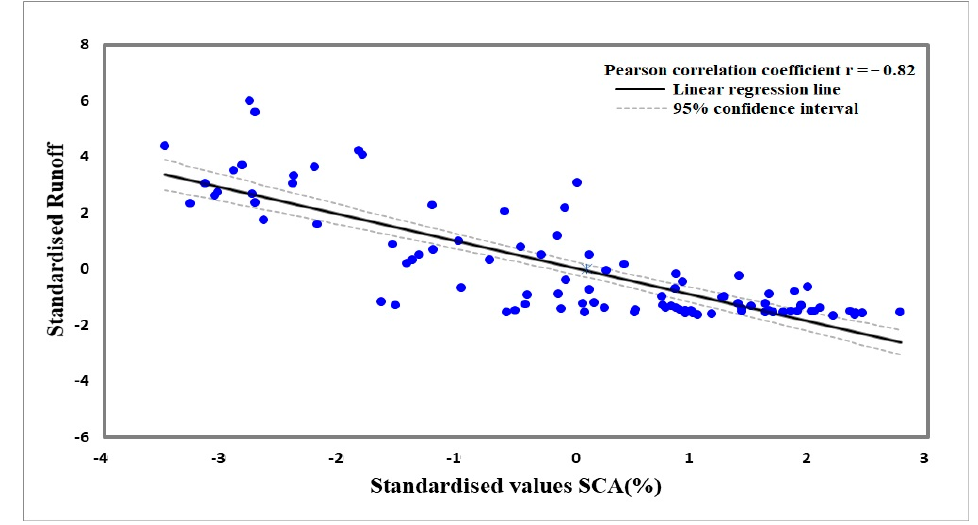
Figure 9. Correlation between standardized values of runoff and SCA.